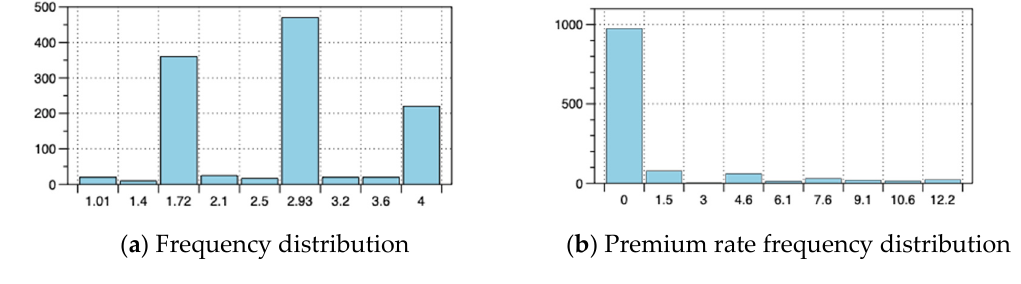
Figure 7. Statistical analysis.